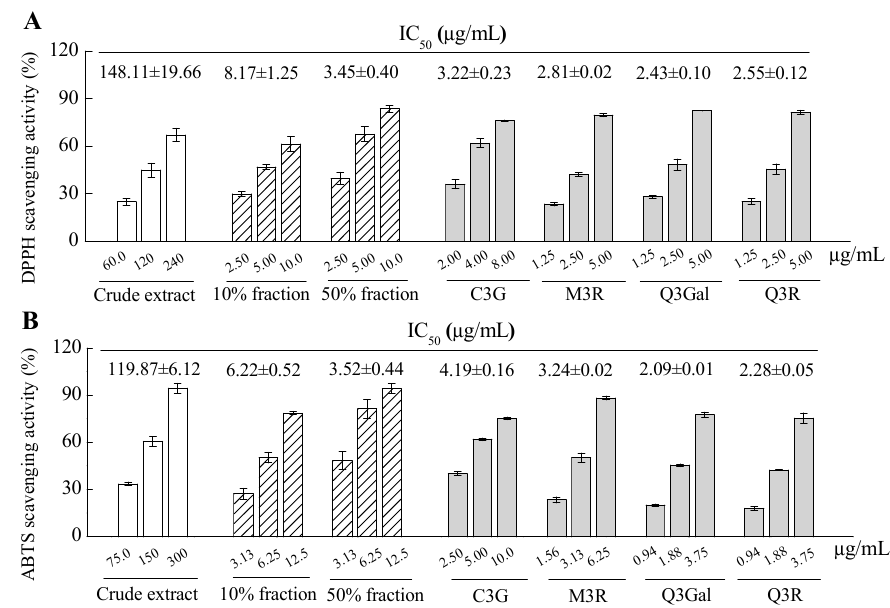
Figure 5. 2.2-diphenyl-1-picrylhydrazyl (DPPH) radical scavenging activity ( A ) and 2.2 ′ -azinobis (3-ethylbenzothiazoline-6-sulfonic acid) diammonium salt (ABTS) radical scavenging activity ( B ) of crude extract, fractions, and isolated and four purified compounds from BQ pulp. Data are presented as the mean ± SD ( n = 3) and IC 50 was calculated for each sample for both assays.